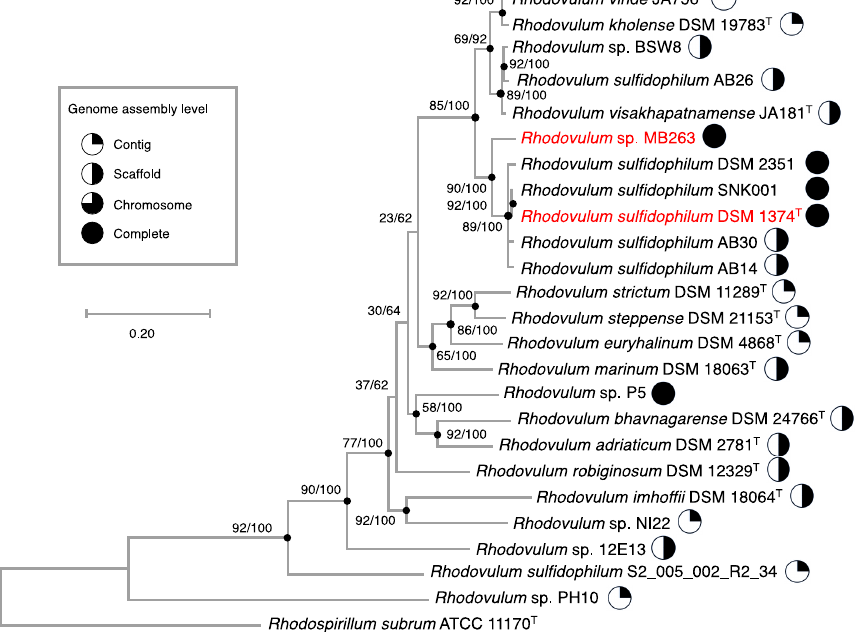
Figure 7. Maximum likelihood phylogenomic tree based on UBCGs (concatenated alignment of 92 core gene sequences) showing genealogical relationships between Rhodovulum sp. MB263 and Rdv. sulfidophilum DSM 1374 T (shown by red letters) or other members of the genus Rhodovulum . The database accession numbers for the sequences incorporated are shown in Table S2. The genome sequence of Rhodospirillum rubrum ATCC 11170 T was used as an outgroup to root the tree. Gene support indices and percentage bootstrap values are given at the nodes of the tree. Scale bar = 0.2 substitution per position.